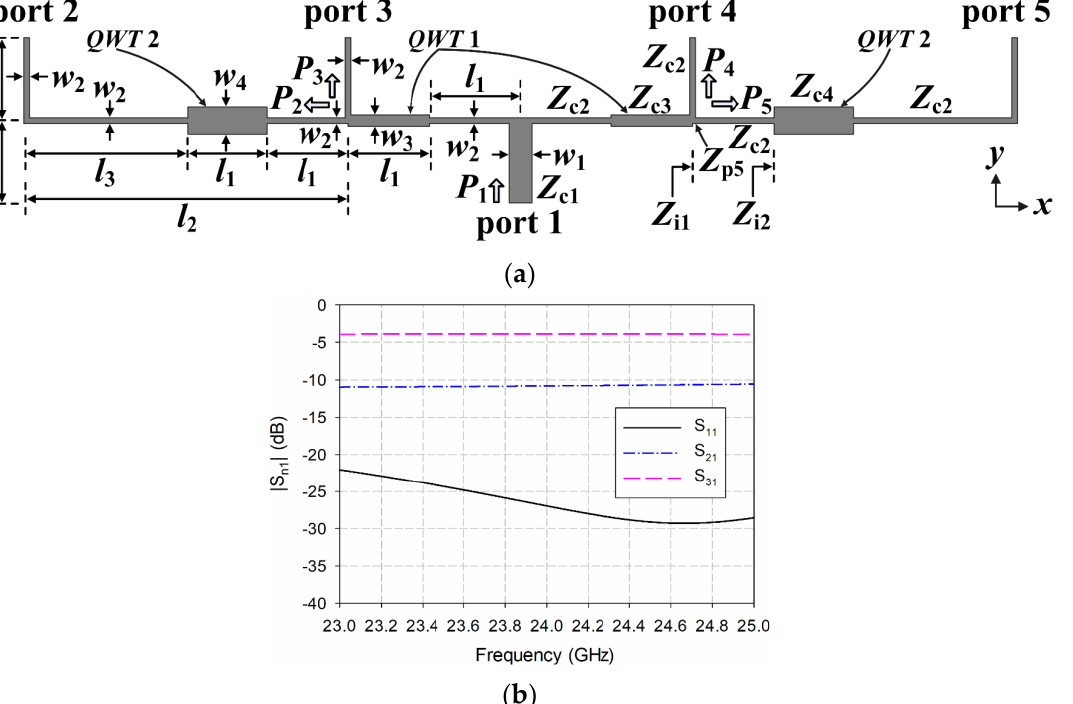
Figure 3. Design and scattering parameter characteristics of the 4 × 1 shunt-connected series feed network using tapered power distribution: ( a ) the geometry and ( b ) scattering